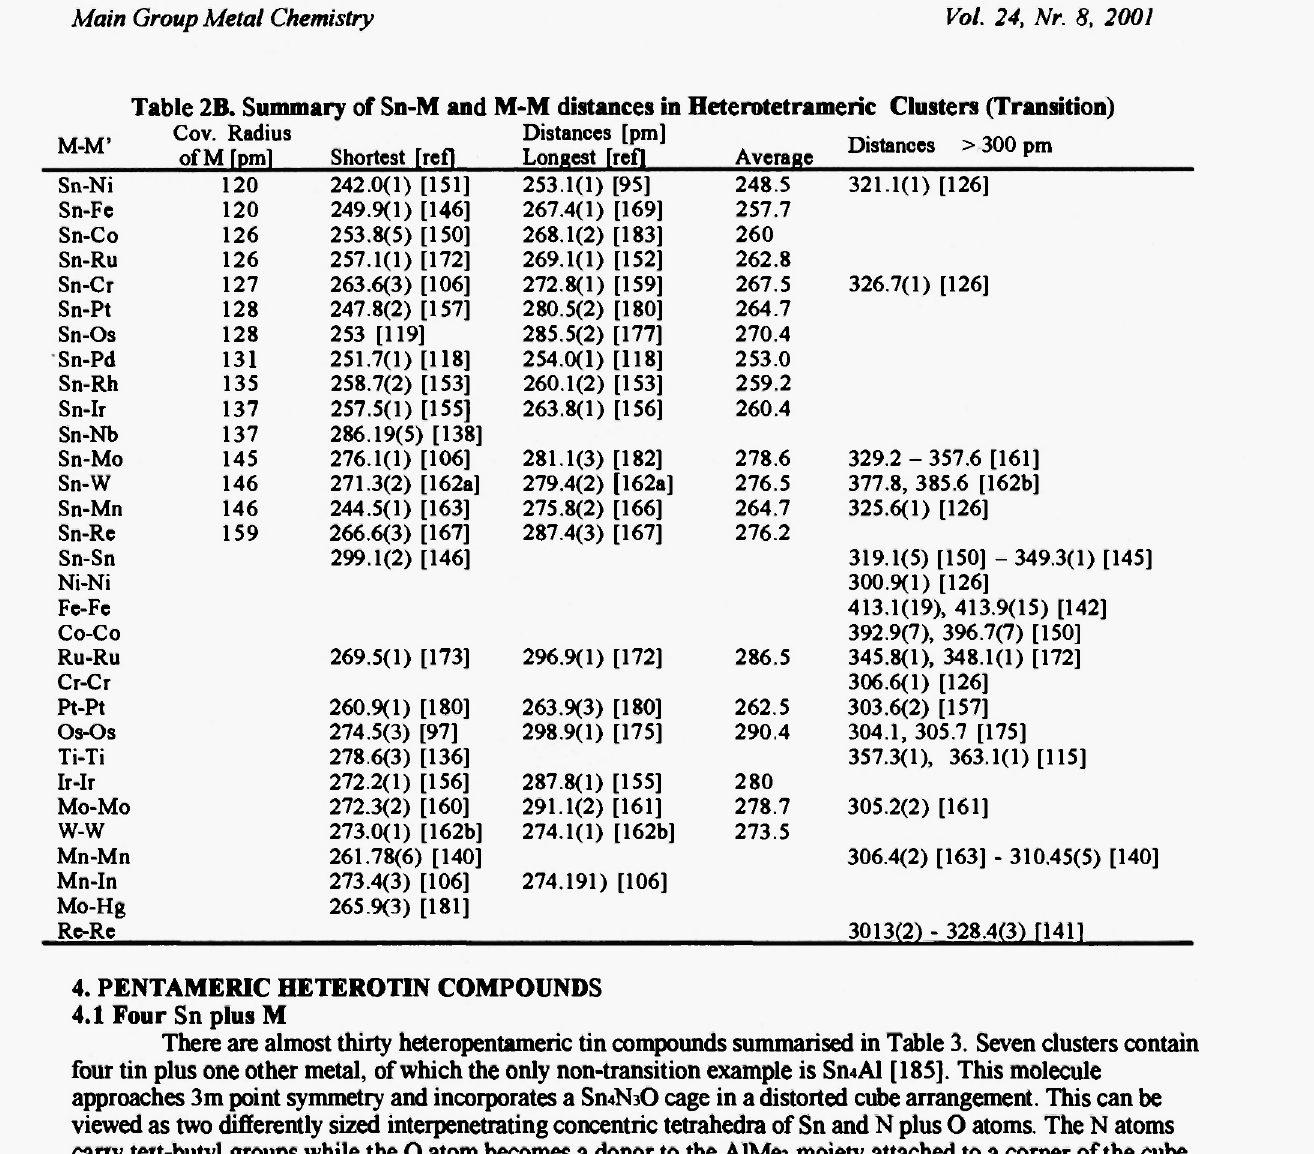
Table 2B. Summary of Sn-M and M-M distances in Heterotetrameric Clusters (Transition)